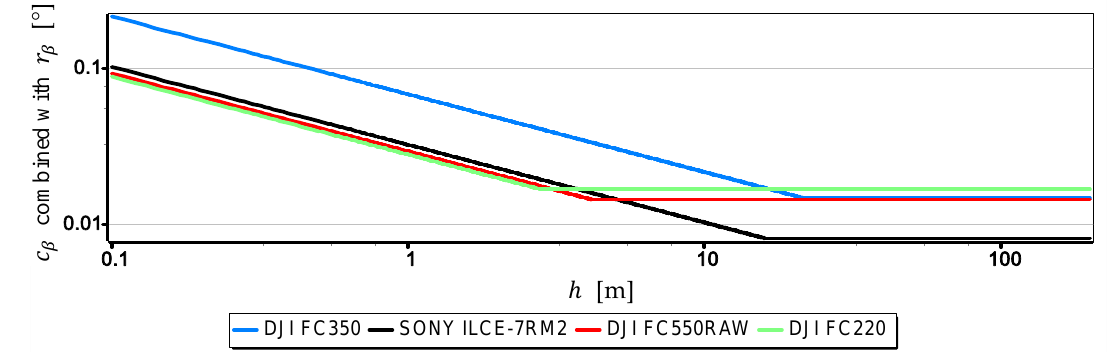
Figure 15. Real measurement resolution of the horizon slope for the wave height " 𝐿 " = 2 m.